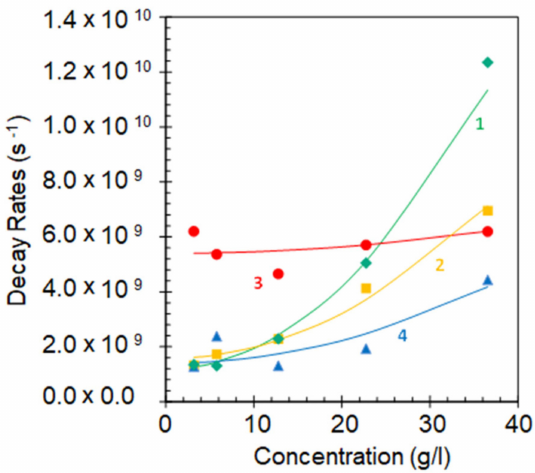
Figure 4. Emission decay rates in HITC:PMMA films at di ff erent dye concentrations on top of glass (trace 1), smooth thermally deposited Au film (trace 2), sub-volumes of the Au foams characterized by short emission kinetics (trace 3), and sub-volumes of the Au foams characterized by long emission kinetics (trace 4). Solid lines are the fits with the formula ( A + W ) + γ n 2 . The spread of emission kinetics is a random process. This may explain larger error bars and poorer fit of the data points forming trace